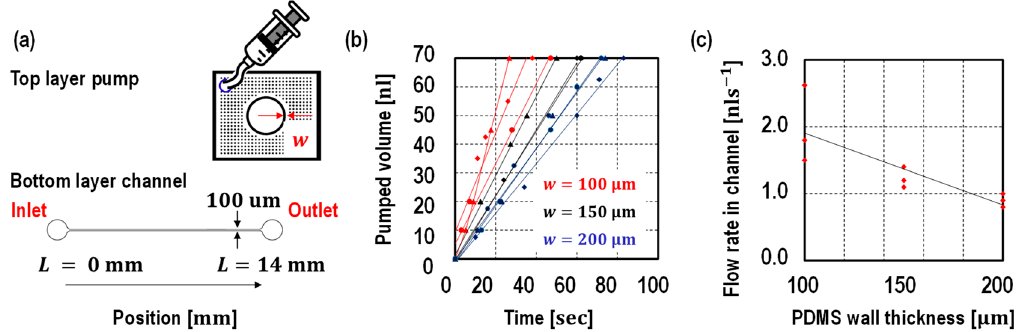
Figure 3. ( a ) Device schematic and ( b ) its measured pumped volume over the time, ( c ) the flow rates against the wall thickness. The PDMS wall thickness were designed to be 100 µm, 150 µm, and 200 µm. The flow time is measured corresponding to the liquid position. As shown in the graph, the pump provided a constant flow rate despite liquid position. The flow rate is inverted proportional to the PDMS wall thickness. All of the devices were tested at least three times.